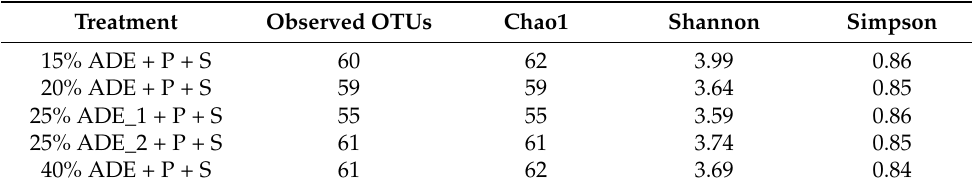
Table 3. Alpha diversity of bacterial communities.